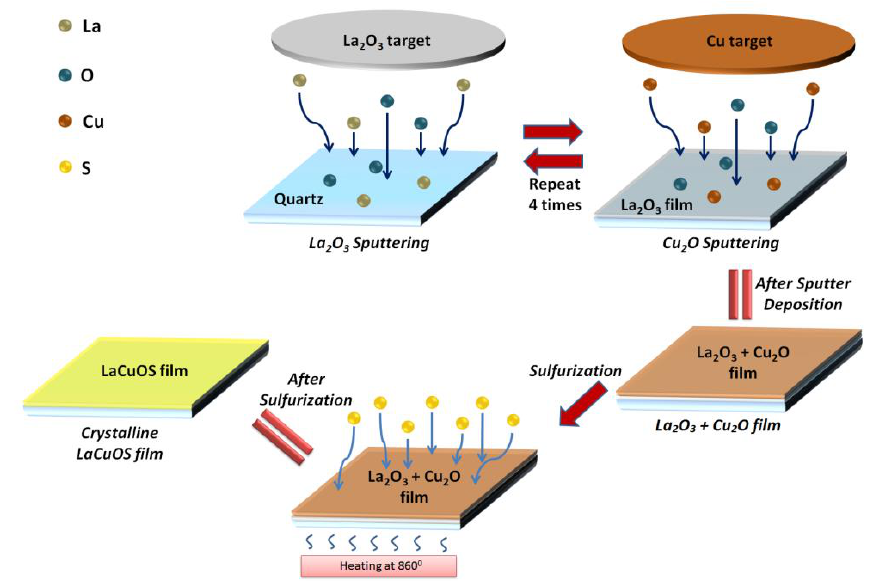
Figure 9. Schematic illustration of the LaCuOS thin film deposition process via sputtering and post-sulfurization. Reproduced with permission from Ref. [196]. Copyright 2018